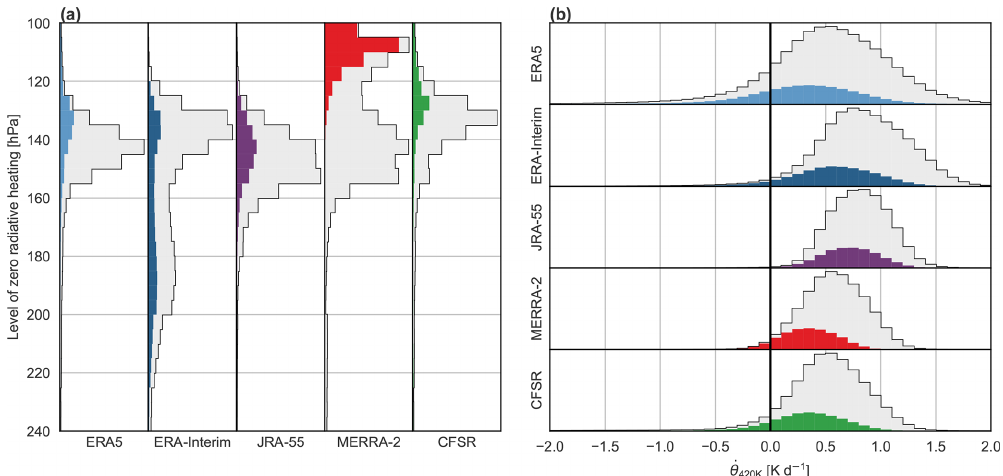
Figure 9. Histograms of (a) the vertical location of the level of zero net radiative heating (LZRH) and (b) the vertical velocity in isentropic coordinates ( ˙ θ on the 420K isentropic surface). Data are based on daily-mean products from (left to right and top to bottom) ERA5, ERA- Interim, JRA-55, MERRA-2, and CFSR during 2001–2010. Colour histograms show distributions for the top quartile of long-wave cloud radiative effect in each reanalysis (see Fig.